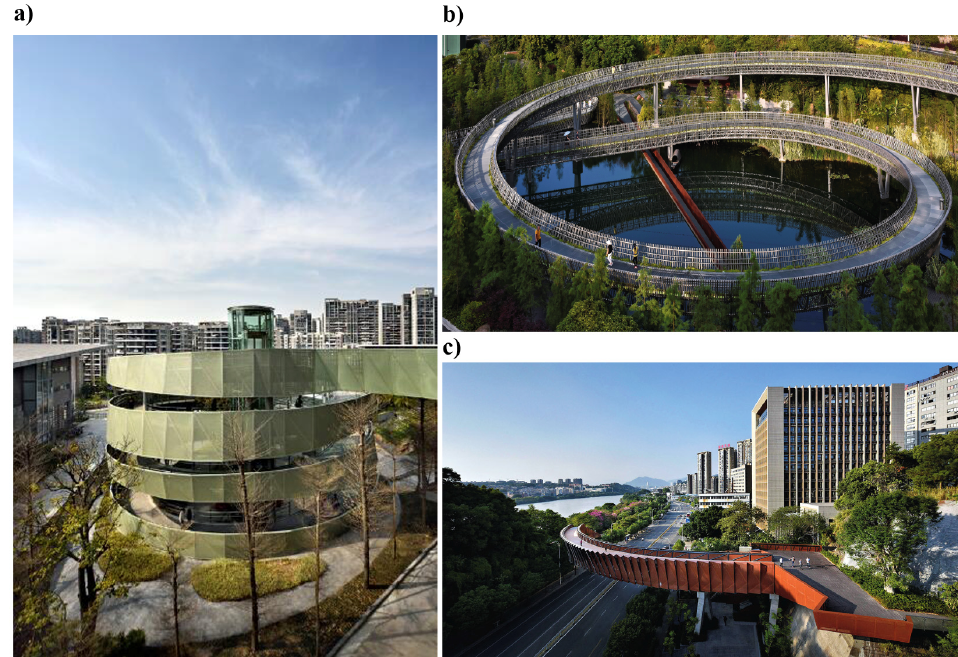
Figure 7. Three locations depicting the outstanding designs of the Fu Forest trail: ( a ) The huge spiral staircase entrance in the north of Jinniu Sports Park; ( b ) the elevated trail above the lake, the spiral circular winding of the steel truss, in the Meifeng Mountainous Park section; and ( c ) the unsupported overhead bridge in the Honggan Road section (Source: author remade according to reference [22]).